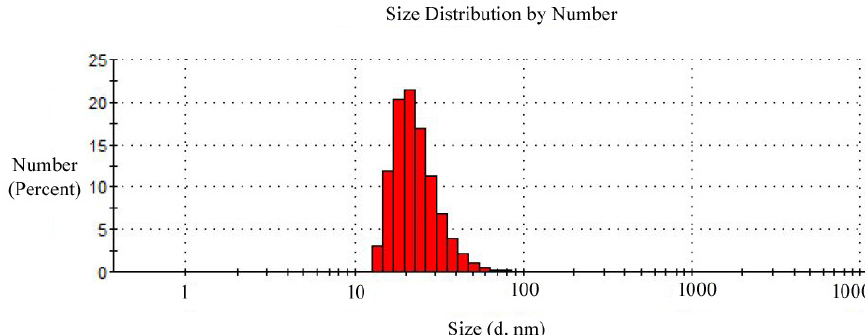
Fig. 9. DLS size distribution by number of G. applanatum extract mediate SNPs